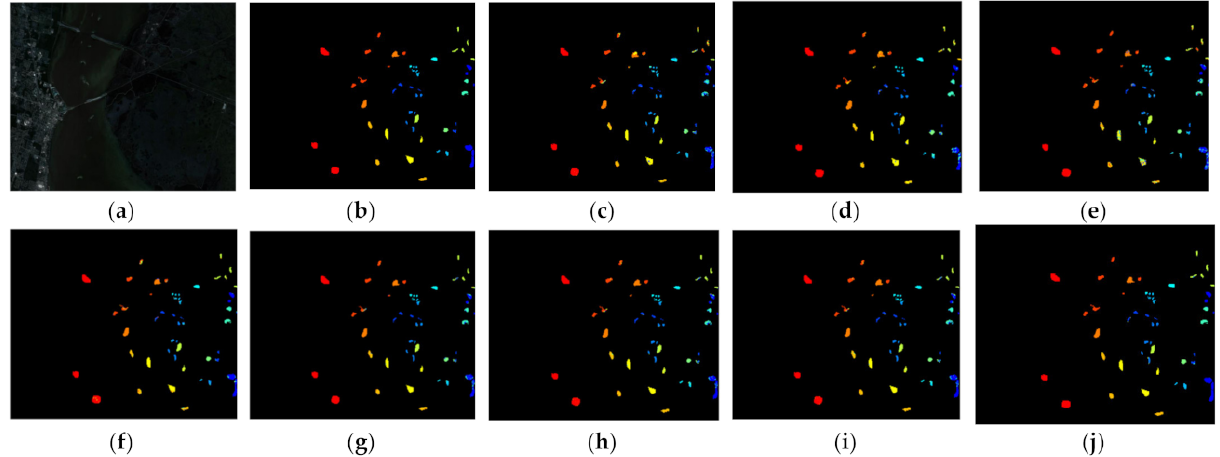
Figure 13. Classification maps obtained by different methods on Kennedy Space Center Dataset.